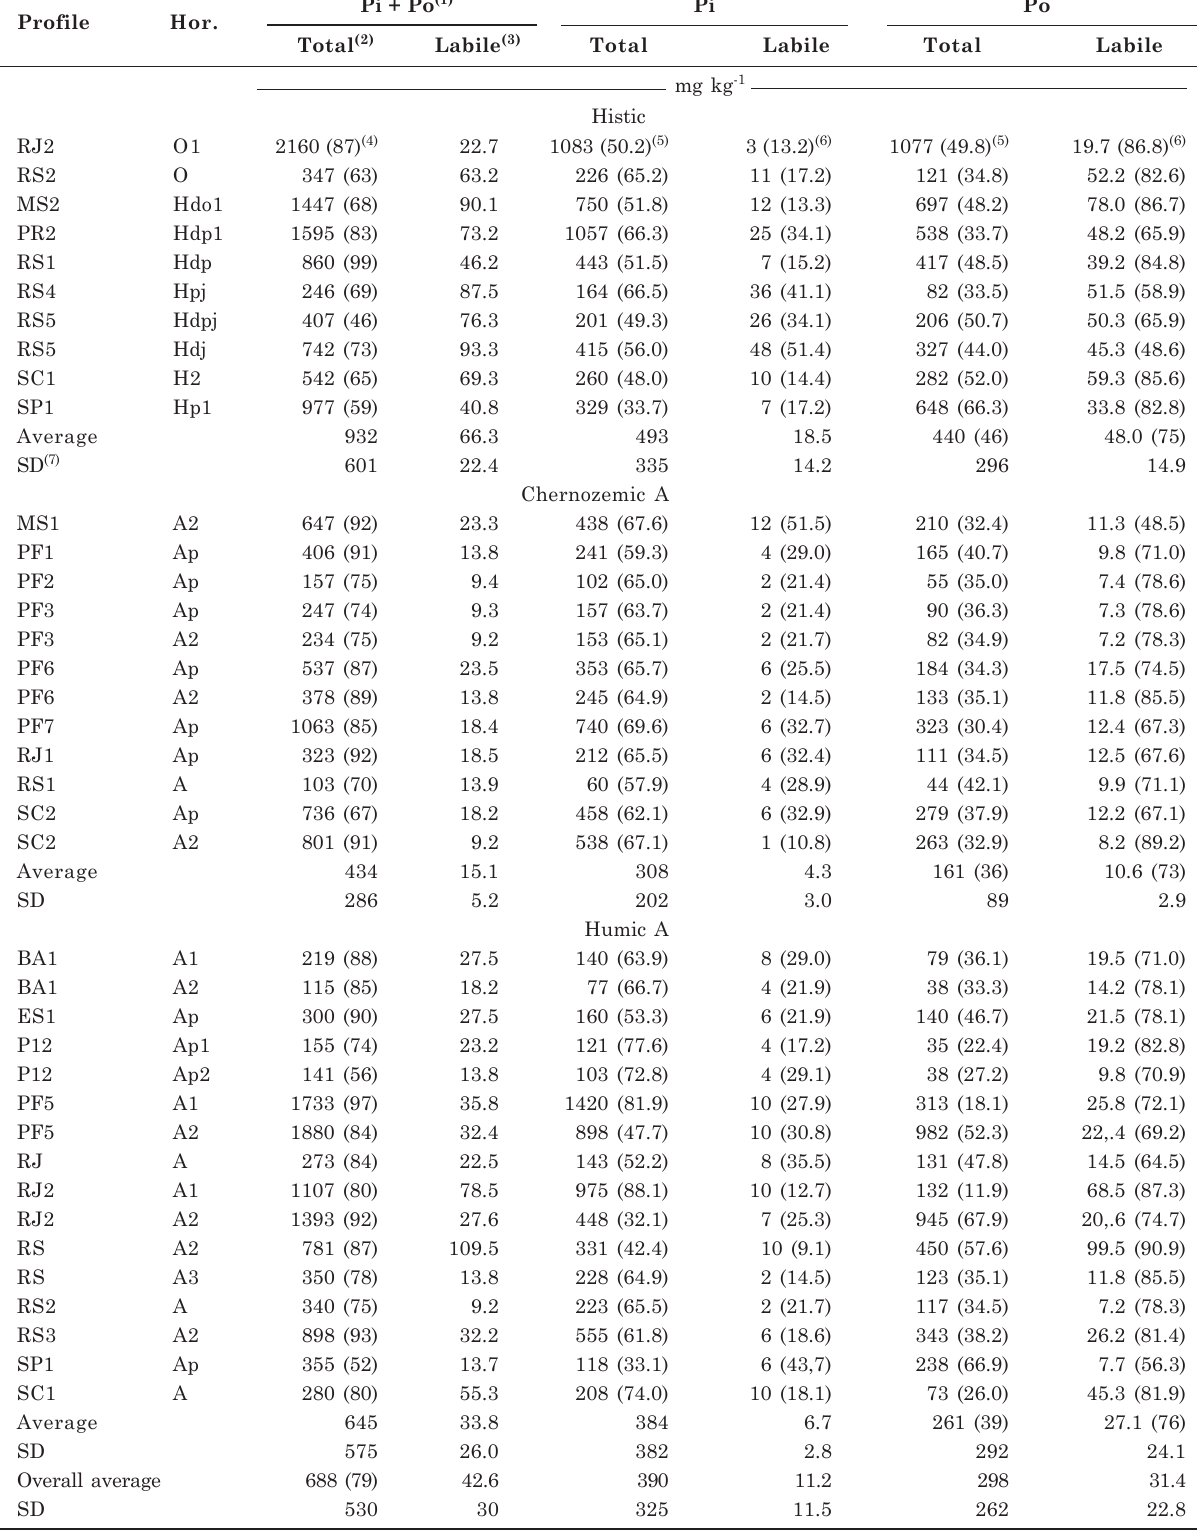
Table 4. P fractions in surface horizons of different soil